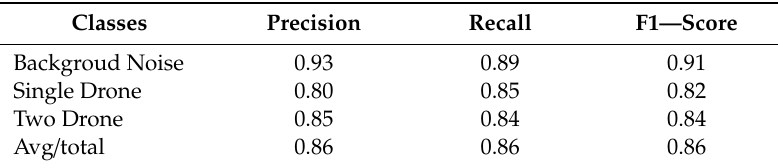
Table 6. Classification Report for CoNN with MFCC.